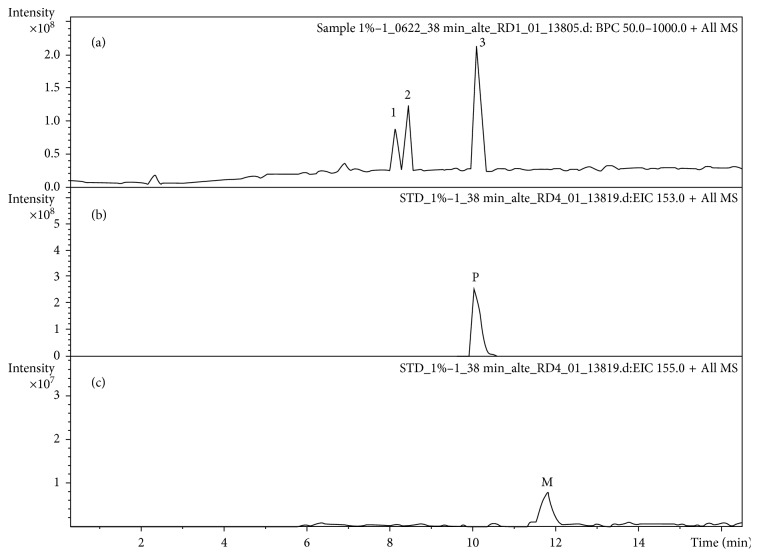
The LC-MS chromatograms of sample (a), pulegone (b), and menthone (c) in positive ion mode.